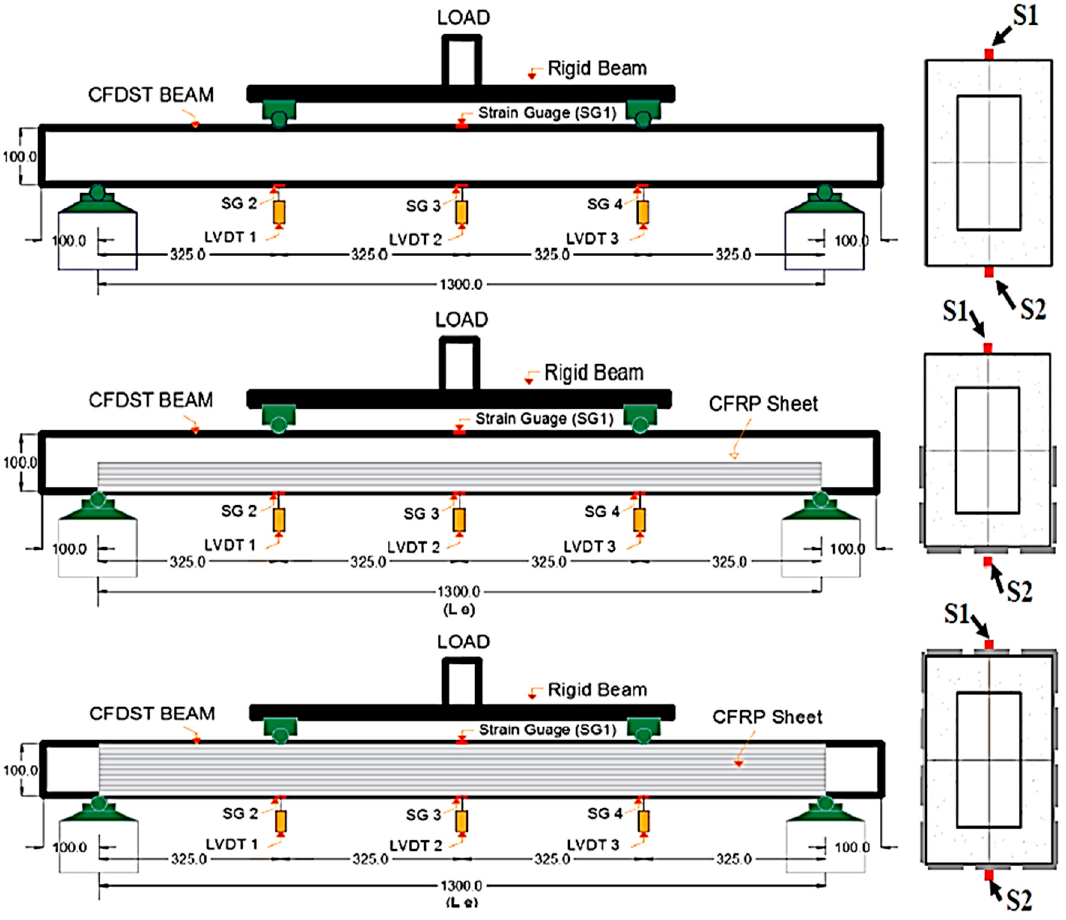
Figure 5. Setup of the test of HPCFDST beams strengthening with CFRP scheme (all units in mm).